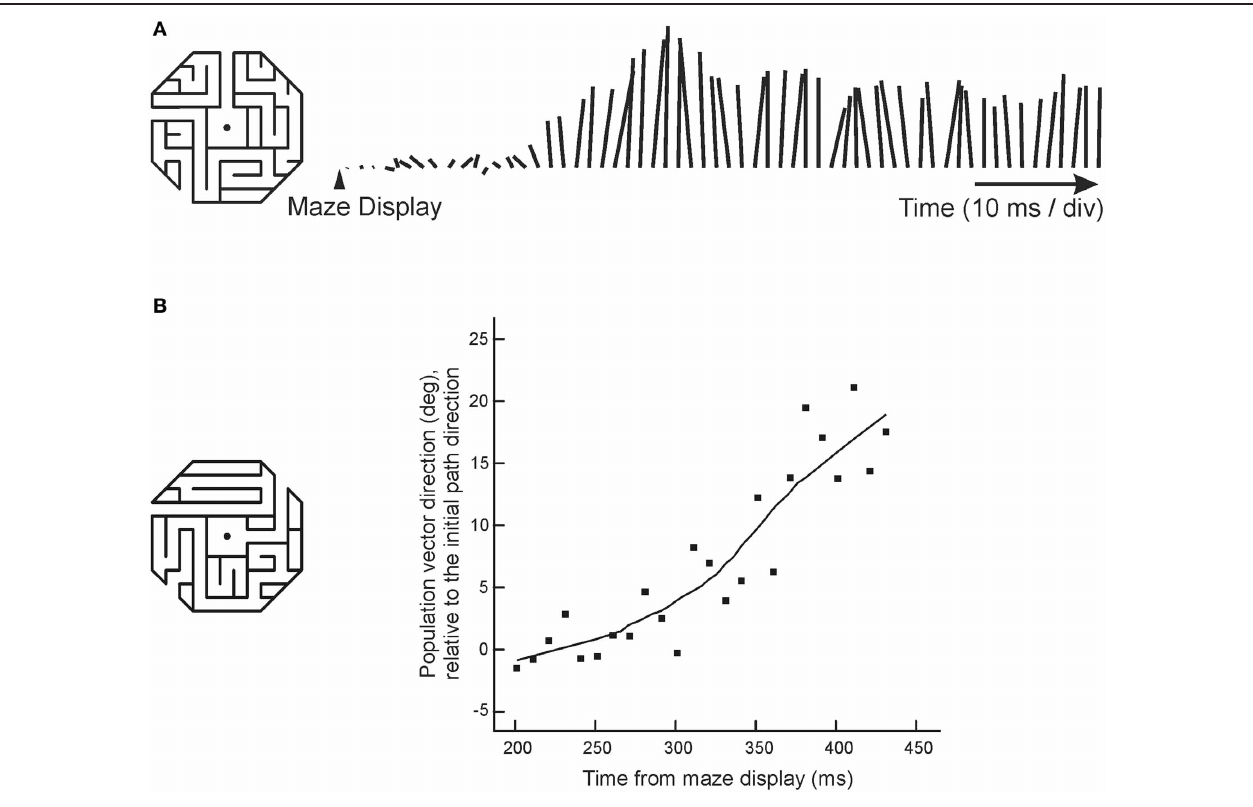
about 200ms, and continued to point up throughout the trial. (B) When monkeys solved mazes with a right-angle turn, the population vector first pointed in the initial path direction and then rotated in the direction that the path turned (positive values in the graph represent angles in the direction the path turned, negative values represent angles away from the